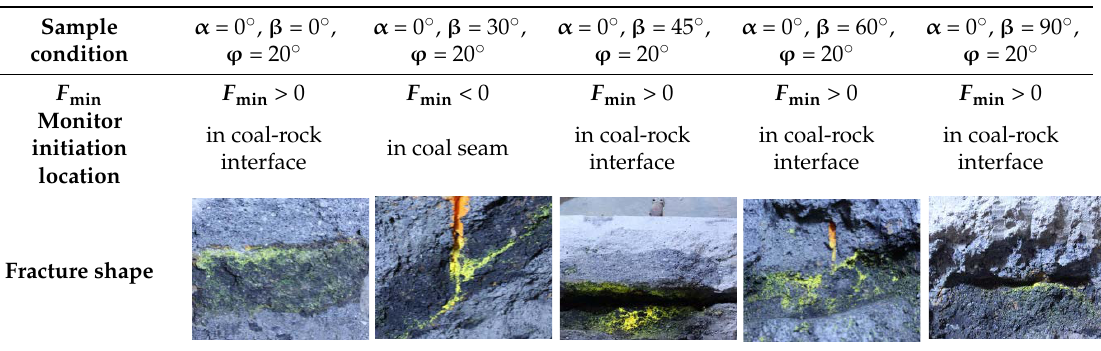
Table 3. Monitor results for initiation locations.